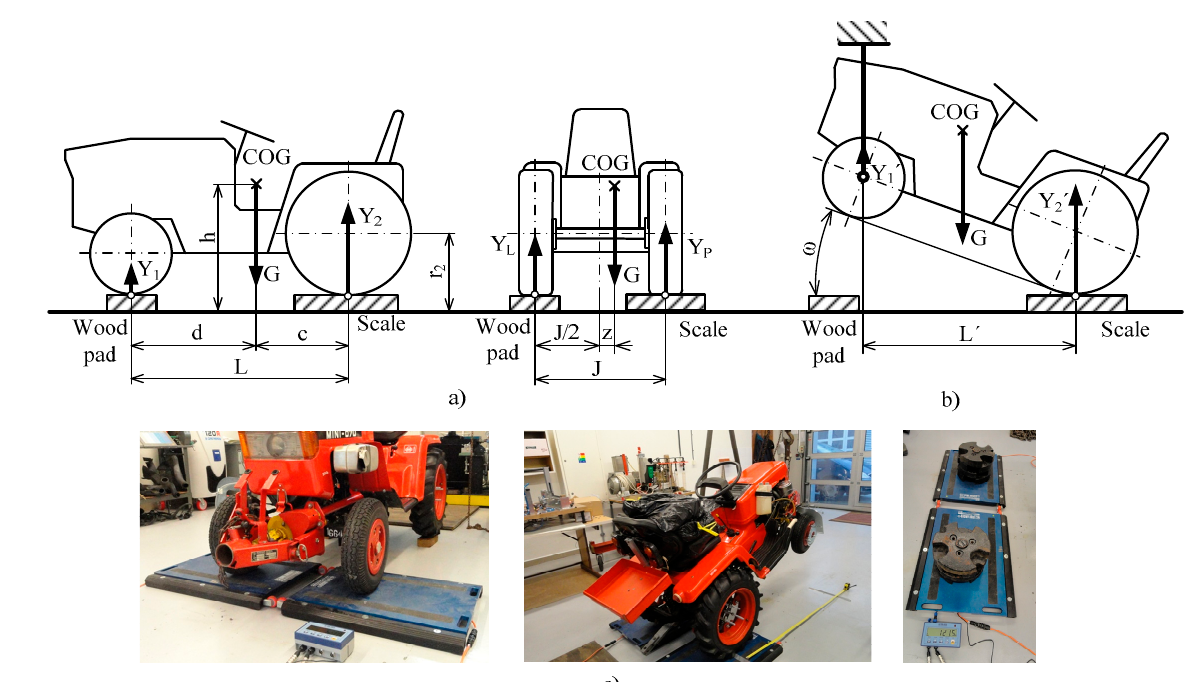
Figure 2. Determination of COG coordinates: ( a ) scheme for calculation of longitudinal coordinate of COG: ( b ) scheme for calculation of vertical coordinates of COG [18], ( c ) weighting scales measuring the reactions of tractor wheels and steel discs (ballast weight): L— wheelbase; c, d— longitudinal coordinates of COG; h— vertical coordinate of COG; J— tread width; G— tractor weight; Y 1 , Y 2 , Y P , Y L ,—ground reactions; r 2 — static rear wheel radius; ω —lifting angle, L´ —vertical projection of wheelbase, Y 1 ´ , Y 2 ´— reaction when the tractor is in raised position.